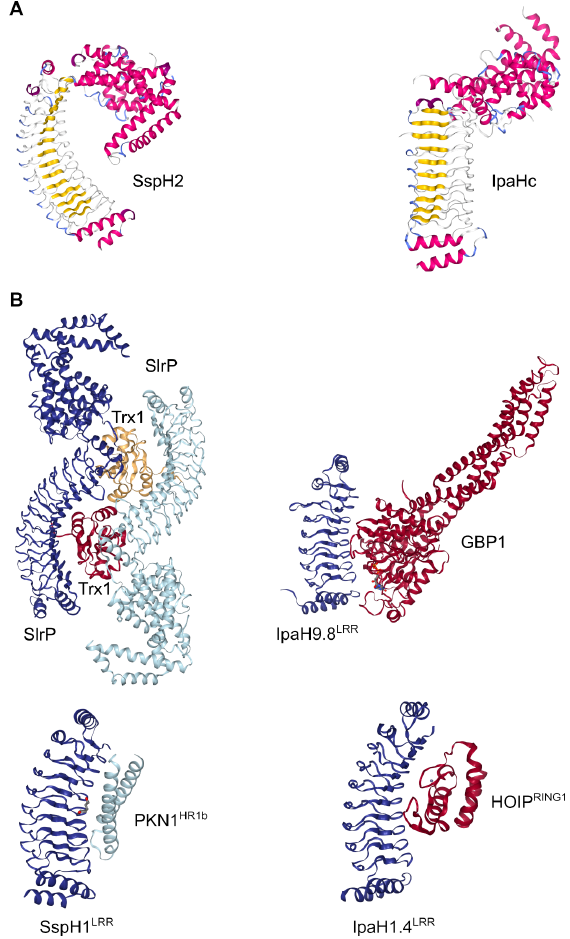
Figure 4. Crystal structures of NEL E3 ligases. ( A ) Examples of the two autoinhibition modes: SspH2, mode 1 (PDB ID: 3G06) [108]; IpaHc, mode2 (PDB ID: 3CVR) [56]. Colors are set according to secondary structure. ( B ) E3 ligases in complex with their substrates: SlrP (blue) in complex with Trx1 (red and yellow) (PDB ID: 4PUF) [179]; the LRR domain of SspH1 (dark blue) in complex with the HR1b domain of PKN1 (light blue) (4NKG) [186]; the LRR domain of IpaH9.8 (blue) in complex with GBP1 (red) (PDB ID: 6LOJ) [185]; and the LRR domain of IpaH1.4 (blue) in complex with the RING1 domain of HOIP (red) (PDB ID: 7V8G) [187]. Drawings created with NGL [191].